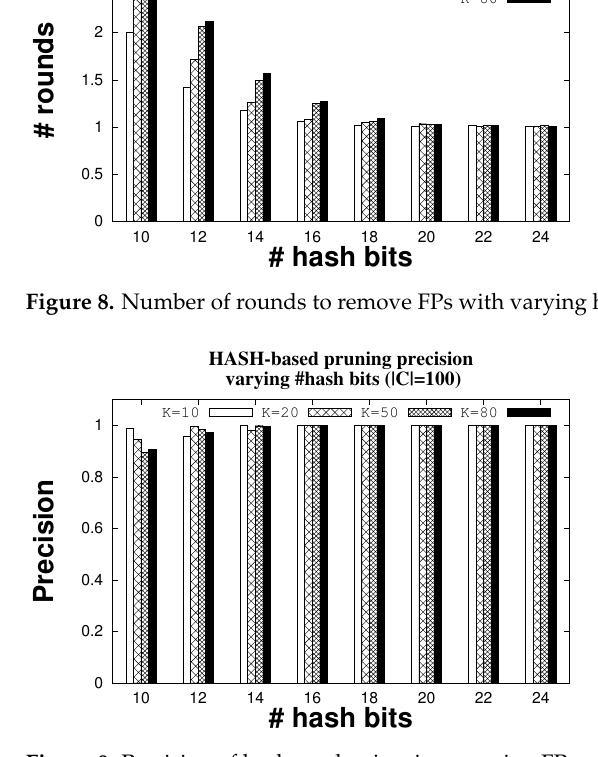
Figure 9. Precision of hash mechanism in removing FPs.